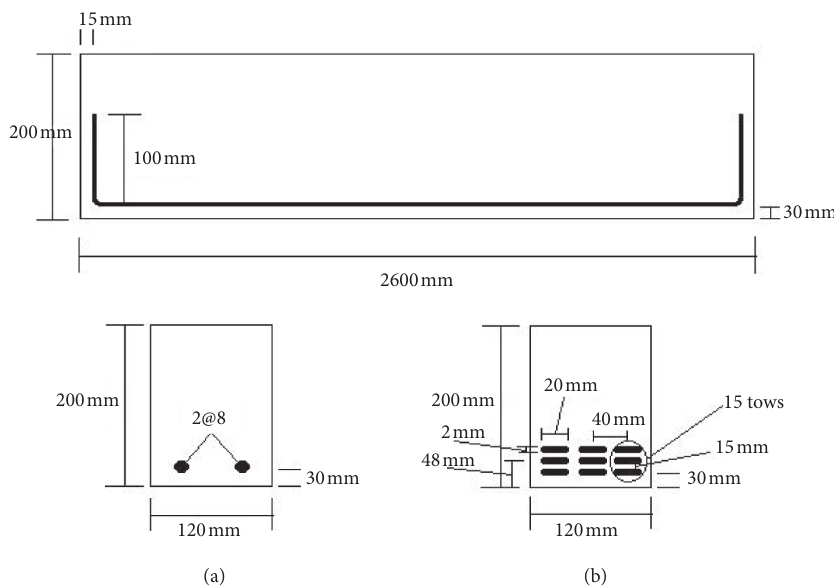
Figure 4: Reinforcement details of the beams. (a) Steel reinforcement and (b) textile reinforcement.